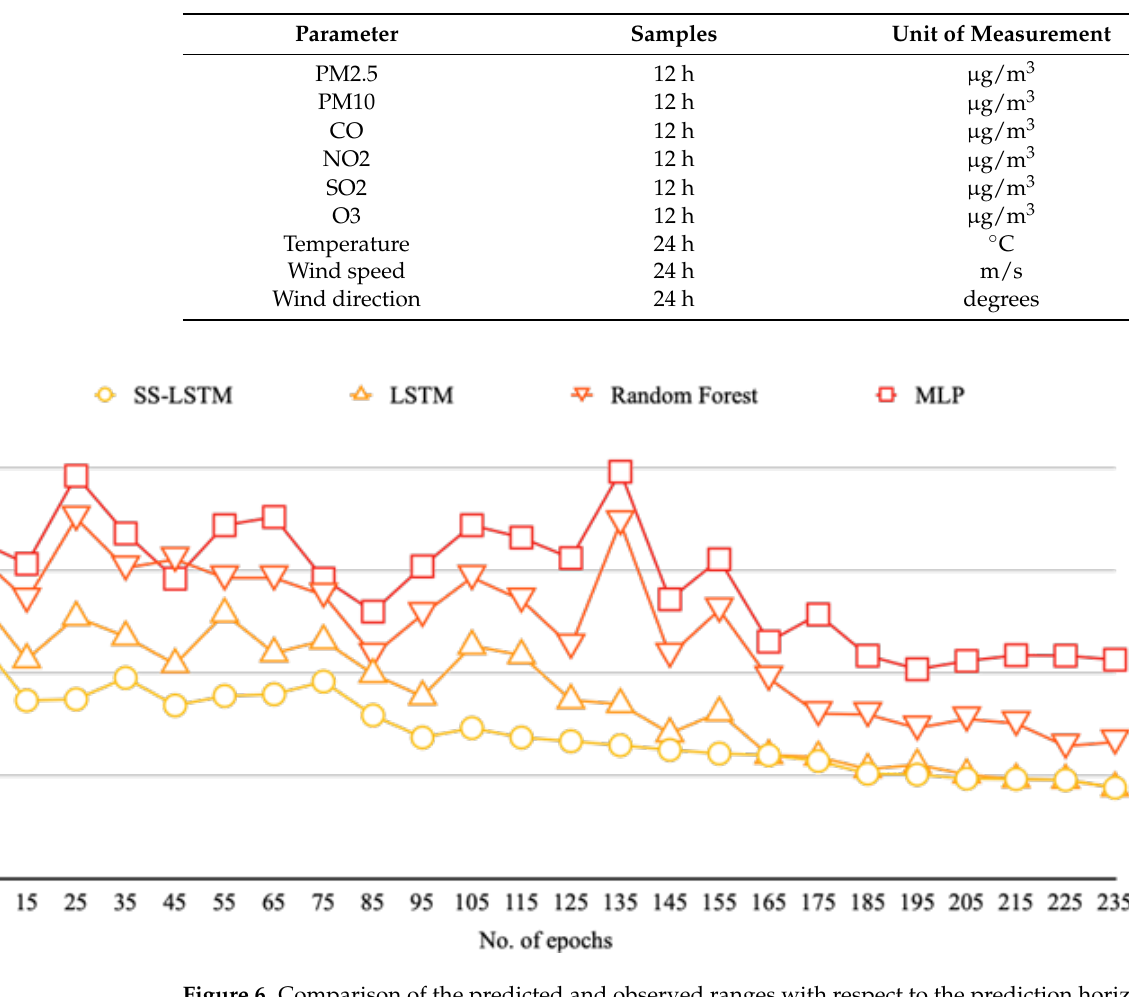
Figure 6. Comparison of the predicted and observed ranges with respect to the prediction horizons in the Delhi locations.